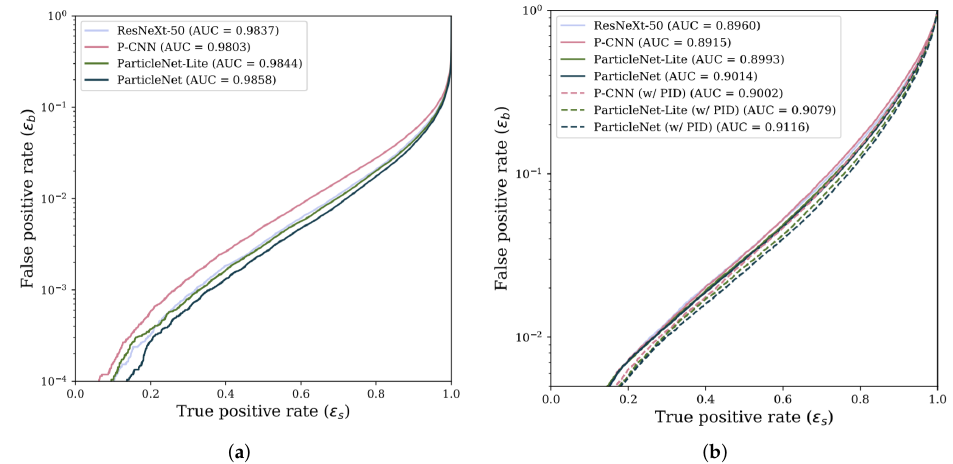
Figure 7. Performance comparison in terms of ROC curves on ( a ) top-tagger and ( b ) quark–gluon